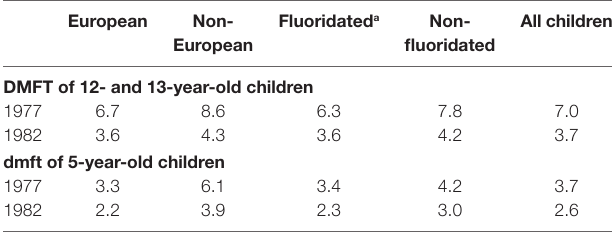
TABLe 2 | The dental caries experience of New Zealand children in 1977 and 1982 (93, 94).